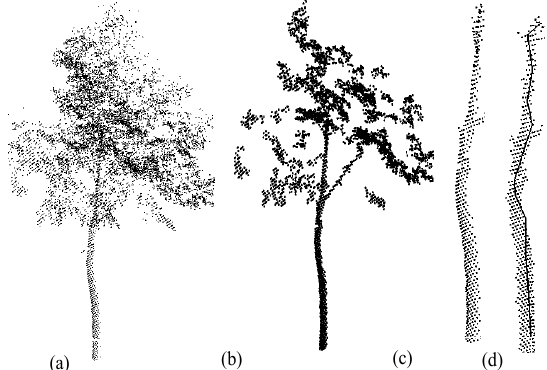
Figure 5. The main stages of the tree stem identification: (a) the input data (original point cloud), (b) the detected tree points after geometric feature estimation for point subsets and removing, (c) the detected tree stem points and (d) the estimated principal direction of the tree stem